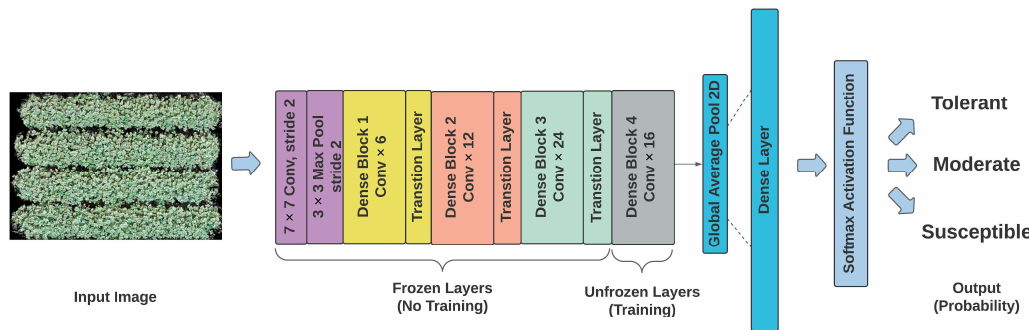
Figure 2. Illustration of the DenseNet121 model architecture.